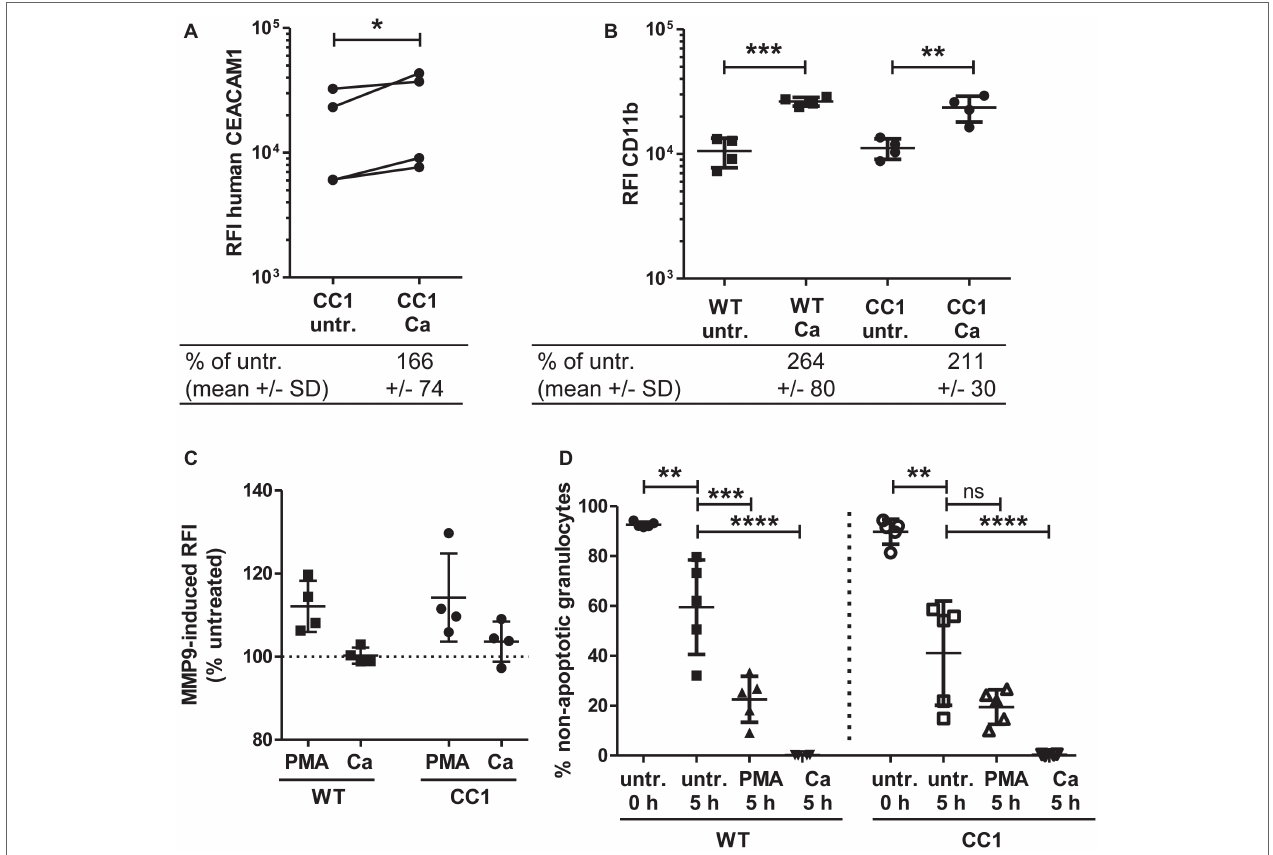
FIGURE 7 | Bone marrow-derived neutrophils (BMNs) from CEACAM1-transgenic mice and WT BMNs have similar cellular properties. BMNs were isolated from femurs of human CEACAM1-transgenic mice (“CC1”) and their wild-type littermates (“WT”). (A,B) BMNs were either left untreated (“untr.”) or stimulated with UV- killed C. albicans germ tubes (MOI 10; “Ca”) for 60 min and analyzed by flow cytometry for their relative fluorescence intensity (RFI) of human CEACAM1 (A) (transgenic BMN only), and of CD11b (B) . Below the graphs, the relative expression of the proteins in the Ca-treated samples compared to the untreated samples is given in percent (mean and standard deviation—SD). Statistical analysis was performed by paired, two-sided Student’s t test of logarithmized data (A) or one-way ANOVA of logarithmized data with Bonferroni post-tests (B) . Please note the lack of cross-reactivity of the anti-human CEACAM1 antibody (A) with mouse CEACAM1 shown in Supplementary Figure 5 . (C) BMNs were either left untreated for 0 or 5 h or were treated with 50 ng/ml phorbol myristate acetate (PMA) or with UV-killed C. albicans germ tubes (MOI 10; Ca) for 5 h. Spontaneous and PMA-/Ca-induced apoptosis was assessed by Annexin V/PI staining with subsequent flow cytometry analysis; the graph shows non-apoptotic granulocytes (Annexin V- and PI-negative) as % of total granulocytes. (D) MMP9 (gelatinase) activity was determined in cell culture supernatants from BMNs that were either left untreated or stimulated with 50 ng/ml PMA or live C. albicans yeast cells (MOI 10) for 60 min by measuring the relative fluorescence intensity induced by the degradation of the EnzCheck DQ-Gelatin -substrate. Data are given as % activity of untreated cells. Statistical analysis of (C,D) was performed by one-way ANOVA with Bonferroni post-tests. * p < 0.05, ** p < 0.01, *** p < 0.005, **** p < 0.001, ns = not